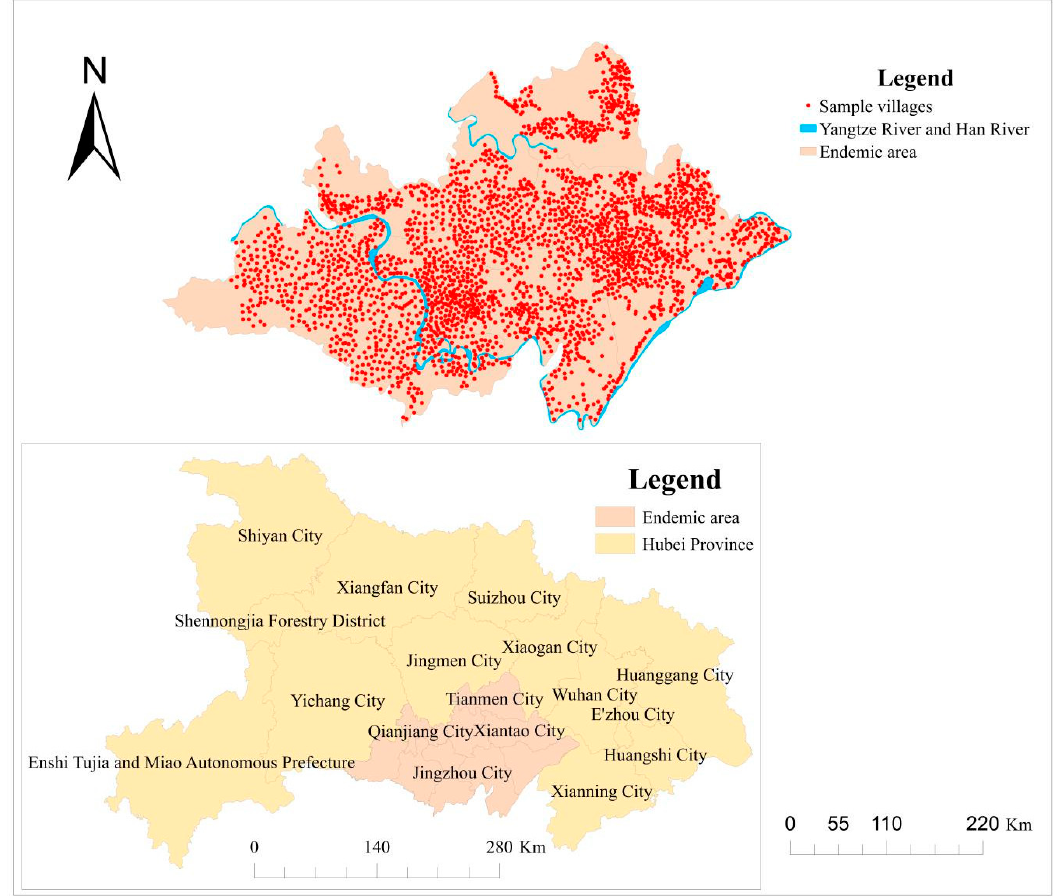
Figure 1. Locations of study area and sample villages.